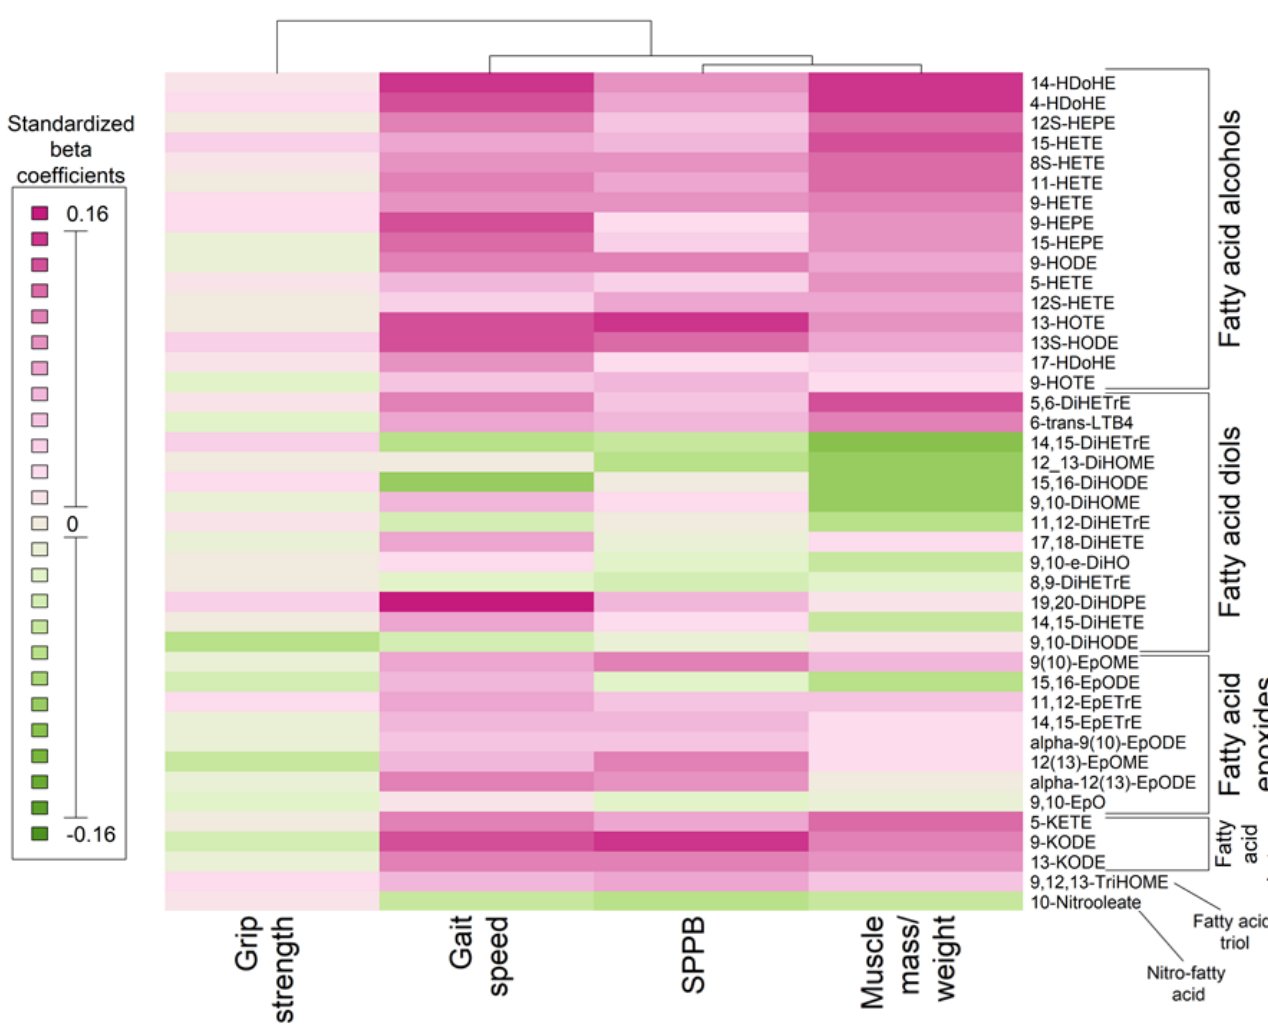
Figure 3. Heatmap of multivariable adjusted associations between oxylipins and physical perfor- mance and D3-creatine muscle mass/weight and a dendrogram of hierarchical clustering of the four outcomes among 463 MrOS men. Models were adjusted for age, more than high school education, Physical Activity Scale for the Elderly, Western style dietary pattern score, and fish oil supplementation. Oxylipin abbreviations are listed in Table S2. Table 1. Characteristics among N = 463 MrOS men by tertiles of gait speed.